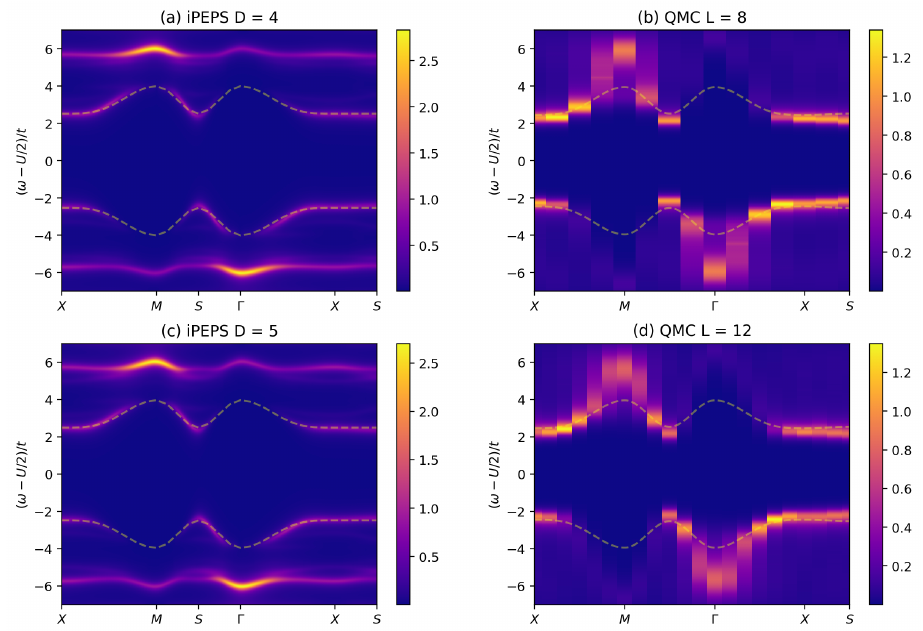
Figure 3: Spectral function at interaction strength U / t = 8 along a path X ( π ,0 ) − M ( π , π ) − S ( π/ 2, π/ 2 ) − Γ ( 0,0 ) − X ( π ,0 ) − S ( π/ 2, π/ 2 ) through the Bril- louin zone for bond dimensions. (a,c) iPEPS results for bond dimensions D = 4,5. (b,d) QMC results for system sizes L = 8,12. The dashed curves in each plot are spin-polaron dispersions [ 61 ] , fitted to the iPEPS